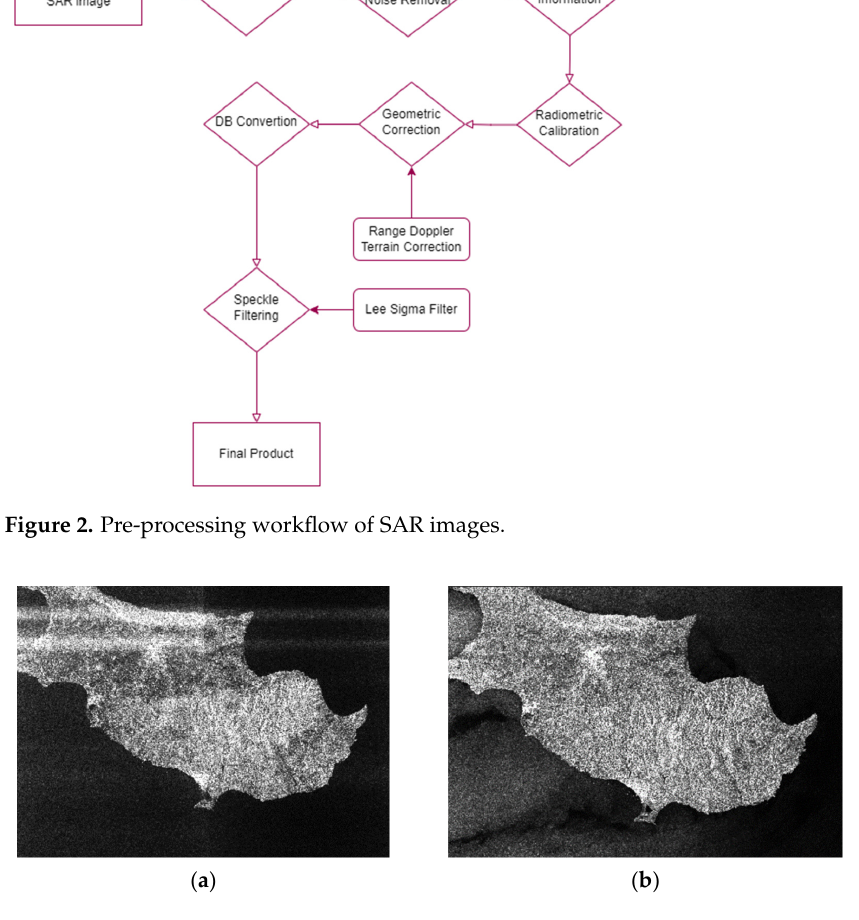
Figure 2. Pre-processing workflow of SAR images.